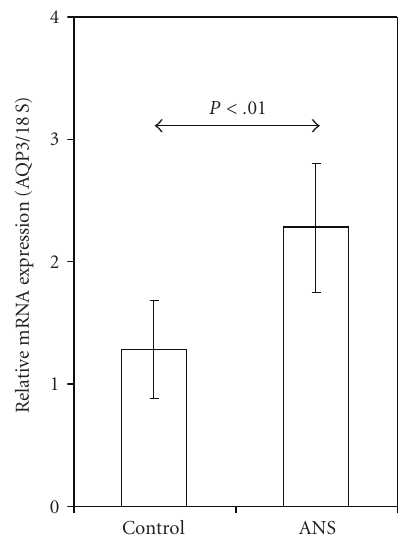
Figure 4: AQP3 mRNA expression (ratio of AQP3 to 18S) is higher in the skin of embryonic day 18 rat pups exposed to antenatal corticosteroids (ANSs; n = 6) than in skin of unexposed controls (Control; n = 6). Values are presented as means ±